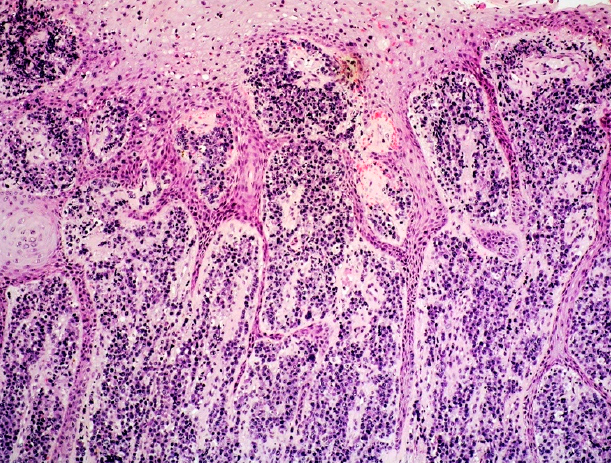
Figure 10. Cutaneous localization of PBL: medium-power view showing a dermal infiltrate lacking epidermotropic features and a hyperplastic epidermis (HE, magnification 40×; original image from Prof. SA).